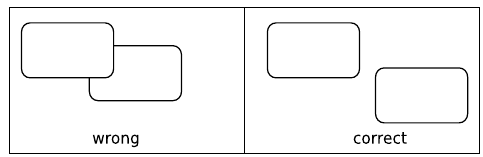
Figure 4.1: Nodes must not overlap.